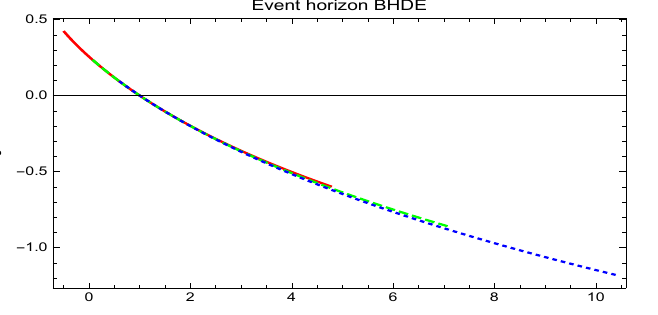
Figure 11. Variation of parameter r versus s for interaction BHDE model with Hubble horizon in the context of GDP braneworld cosmology.